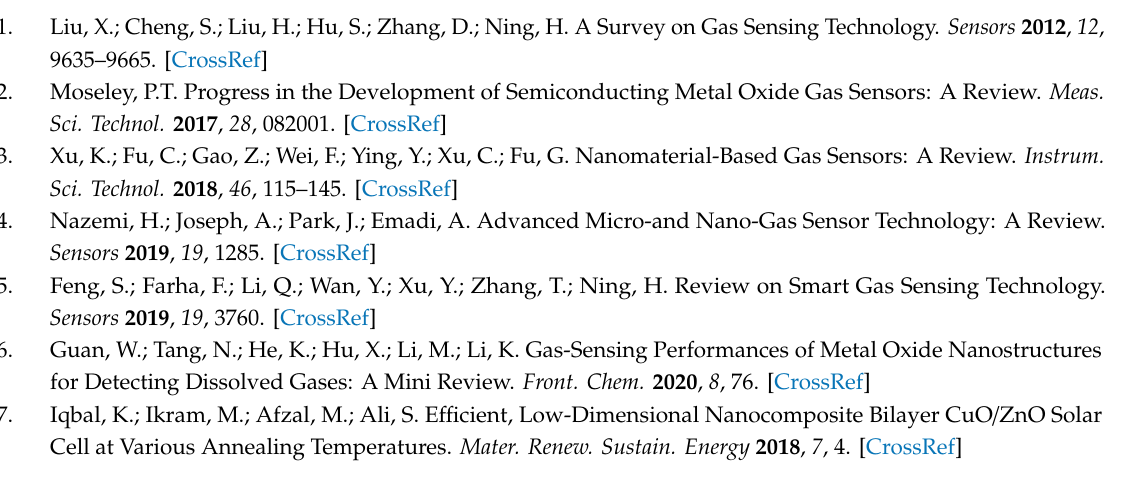
FigureS1: Gallium / copperconcentrations: (a)distributionmapofsampleS1forCuandGaelements, (b)distribution map of sample S2 for Cu and Ga elements, (c) distribution map of sample S3 for Cu and Ga